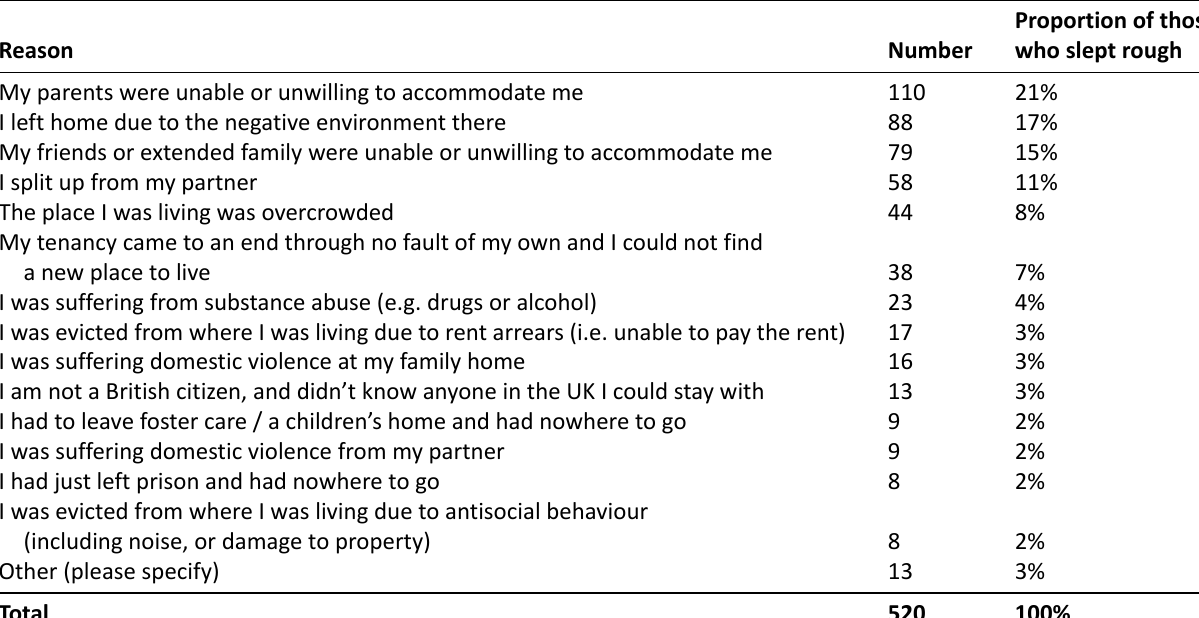
Table 2. “Which, if any, of the following reasons explain why you had nowhere else to stay? (All those who have rough